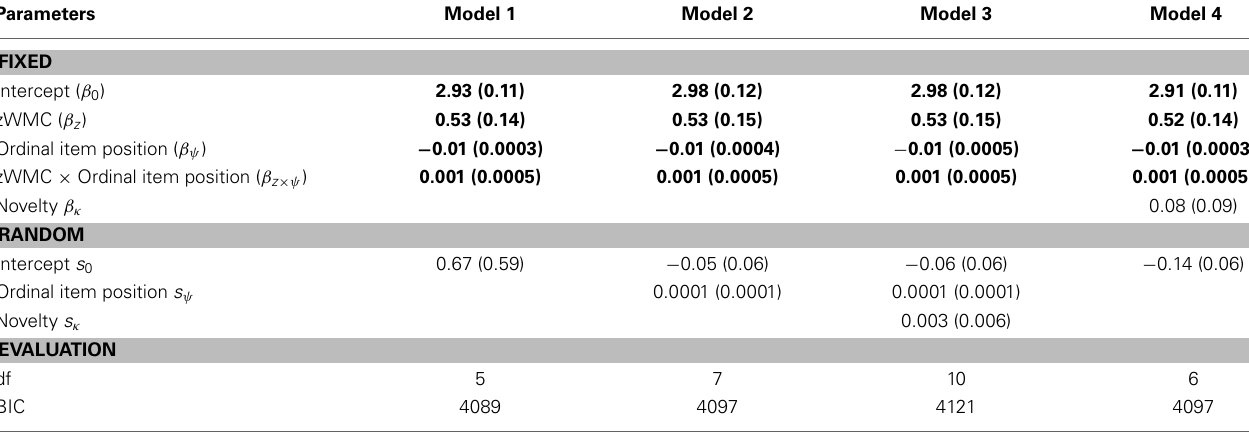
Table 2 | Estimated parameters (and standard errors) of mixed effects modeling of the RAPM behavioral